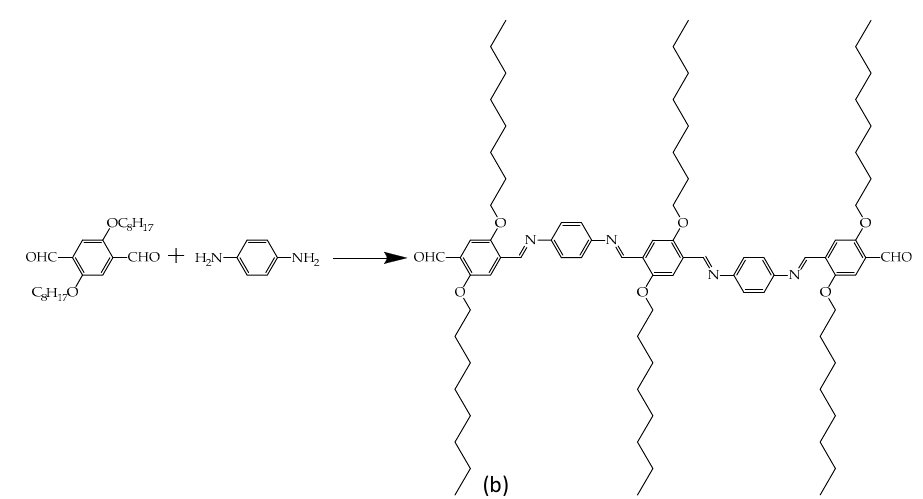
Figure 1. Synthesis of conjugated oligophenyleneimines: ( a ) DAFCHO; and ( b ) FDACHO. FT-IR spectroscopy was used to characterize the DAFCHO and FDACHO oligomers (Figure 2). The results show the emergence of vibrational bands at 3050 cm − 1 and 3052 cm − 1 , corresponding to the aromatic C-H bonds. The vibrational bands at 2919 cm − 1 , 2851 cm − 1 , 2923 cm − 1 and 2854 cm − 1 , corresponding to the (C-H) of aldehyde (CHO), methylene (CH 2 ) and methyl (CH 3 ) groups, originate from the aliphatic chains. The vibrational bands at 1594 and 1579 cm − 1 are linked to the vibration of the groups (C=C), while the vibrational bands at 1680 and 1682 cm − 1 emerge due to the (C=O) bond, generated by the terminal aldehyde groups (CHO). Finally, the formation of the imine bonds (C=N) were observed at 1613 and 1610 cm − 1 . Molecules 2018 , 23 , x FOR PEER REVIEW 4 of 14